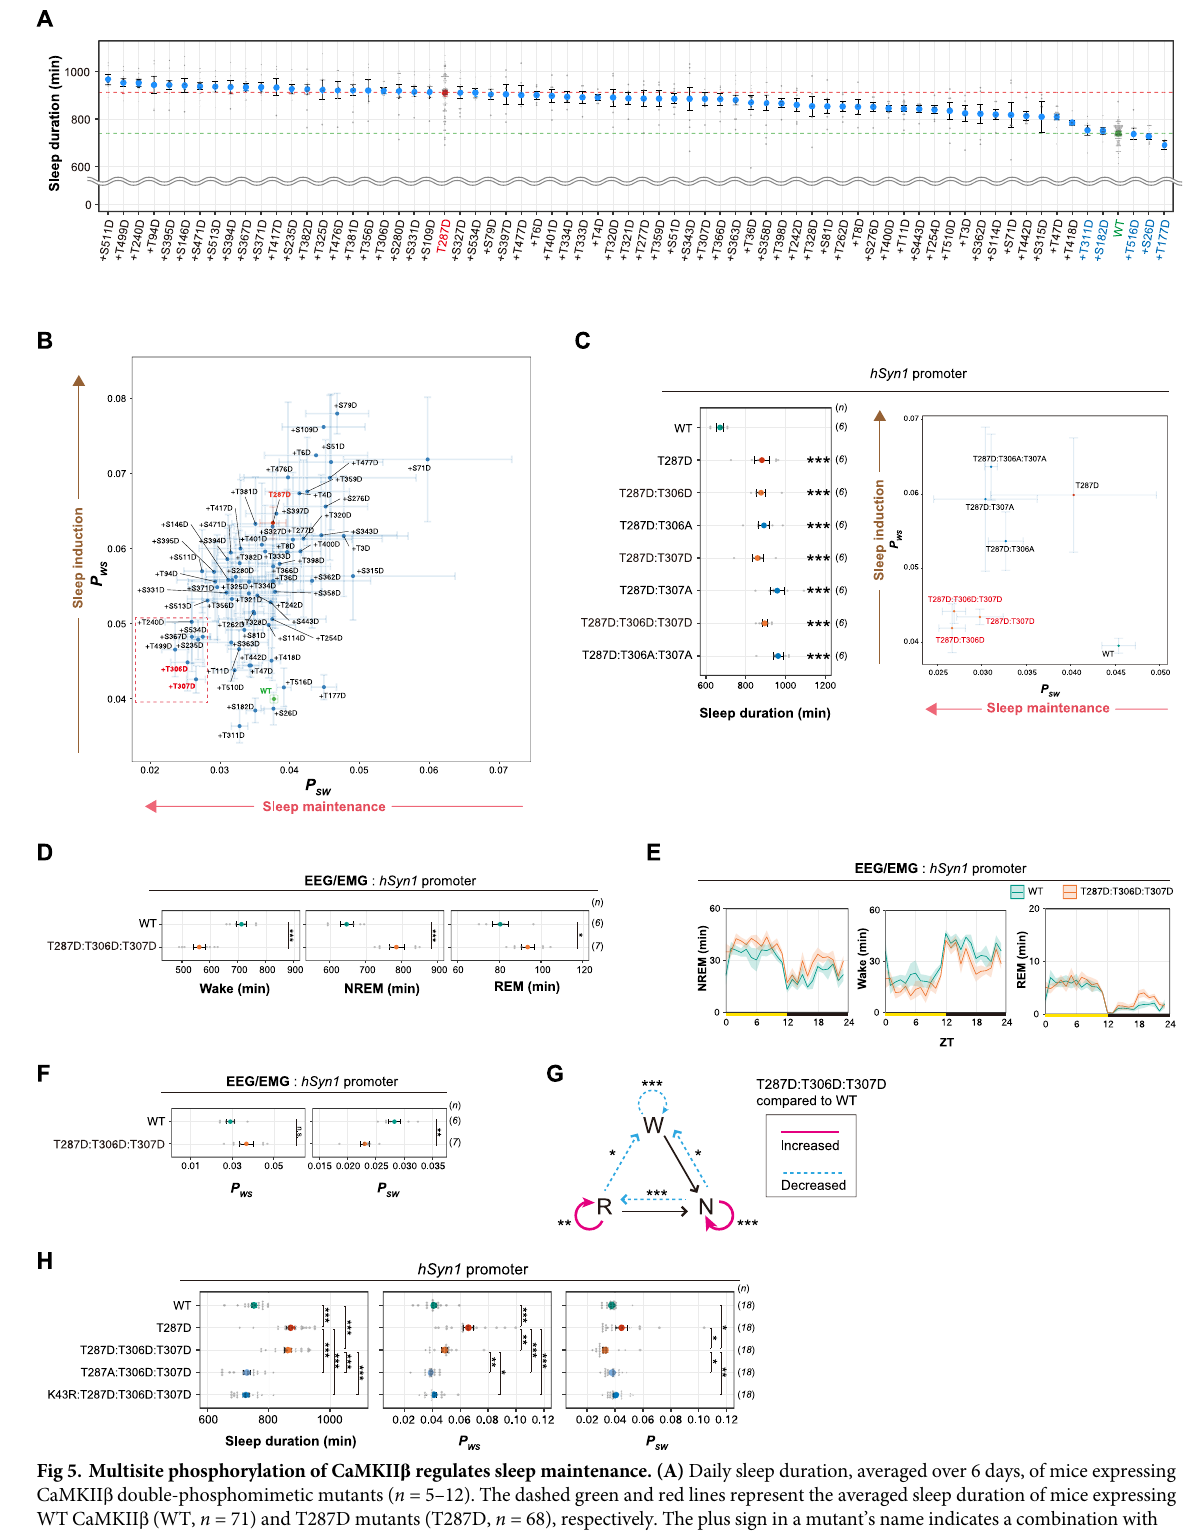
PLOS Biology | https://doi.org/10.1371/journal.pbio.3001813 October 4,